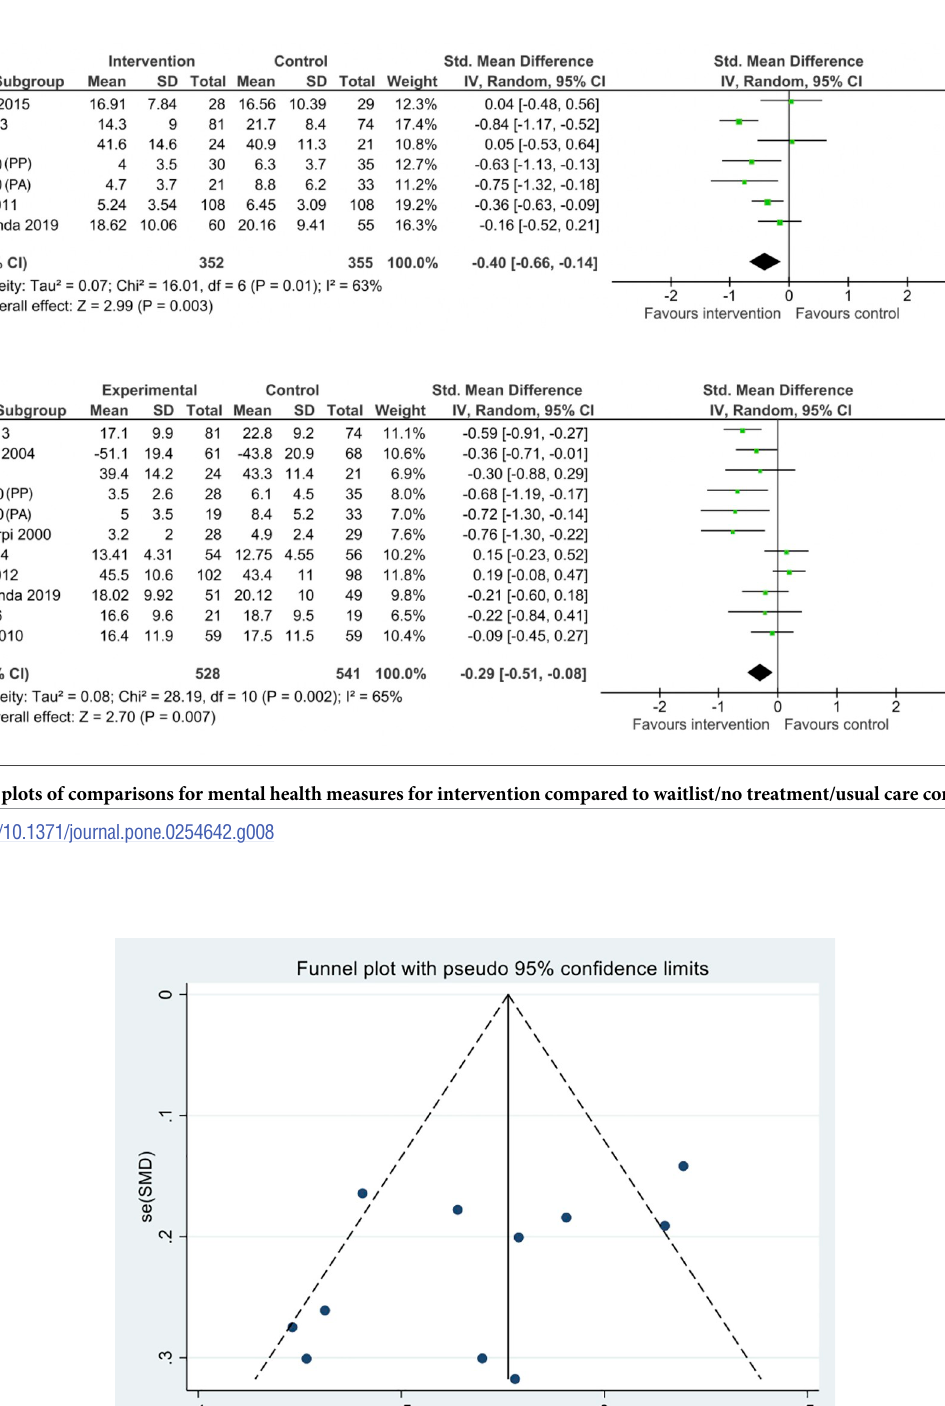
PLOS ONE | https://doi.org/10.1371/journal.pone.0254642 July 16,